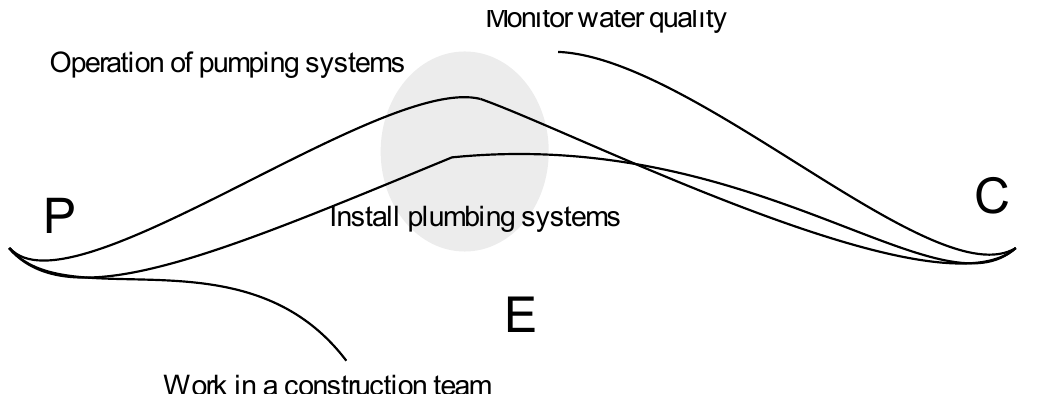
FIGURE 1. PERSON-DELIVERY ENVIRONMENT-CONTEXT MODEL